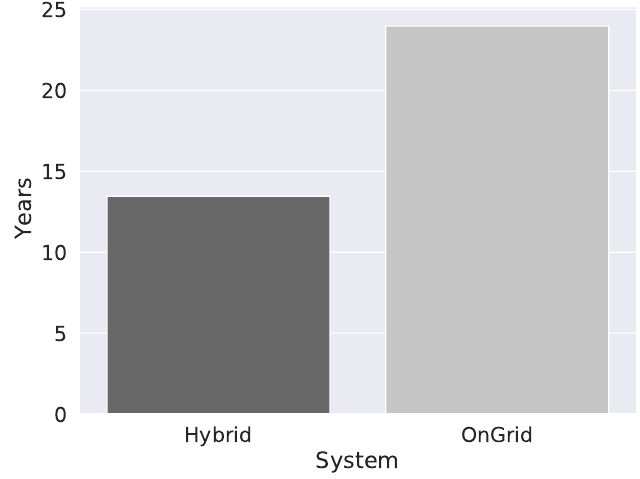
Figure 11. Years to offset all the